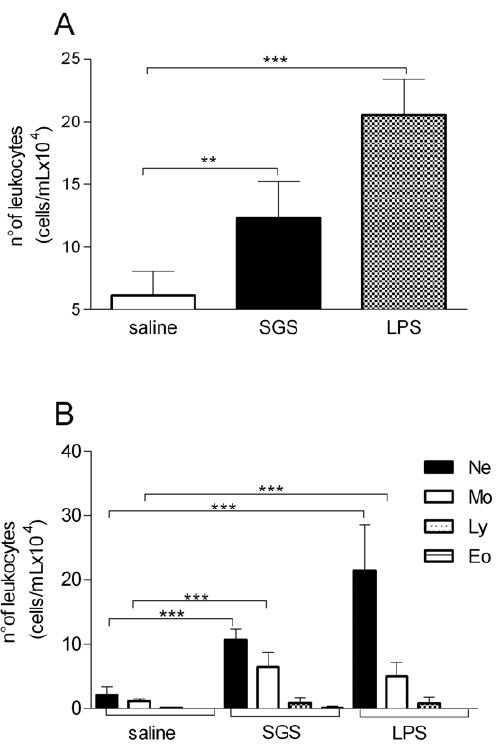
Figure 1. Leukocyte recruitment in air pouch exudates in response to L.intermedia saliva. Air pouches were raised on BALB/c mice (five to six per group) and were inoculated with either endotoxin- free saline, L. intermedia SGS, or LPS. Exudates were collected twelve hours later. Leukocytes were enumerated microscopically. (A) Total number of leukocytes and (B) total number of neutrophils, monocytes, eosinophils, and lymphocytes accumulated in air pouches. The data are representative of three independent experiments. (** P , 0.01; *** P , 0.001).